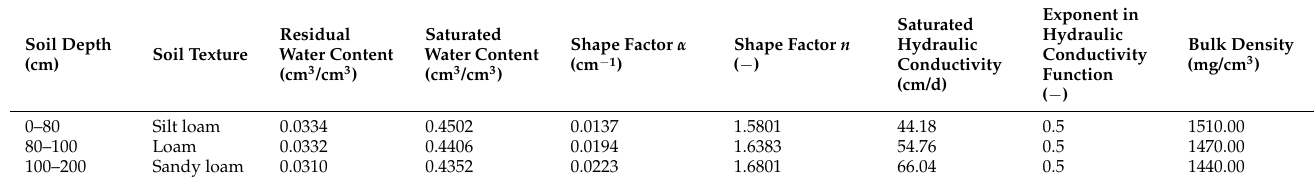
Table A2. Soil hydraulic parameters.